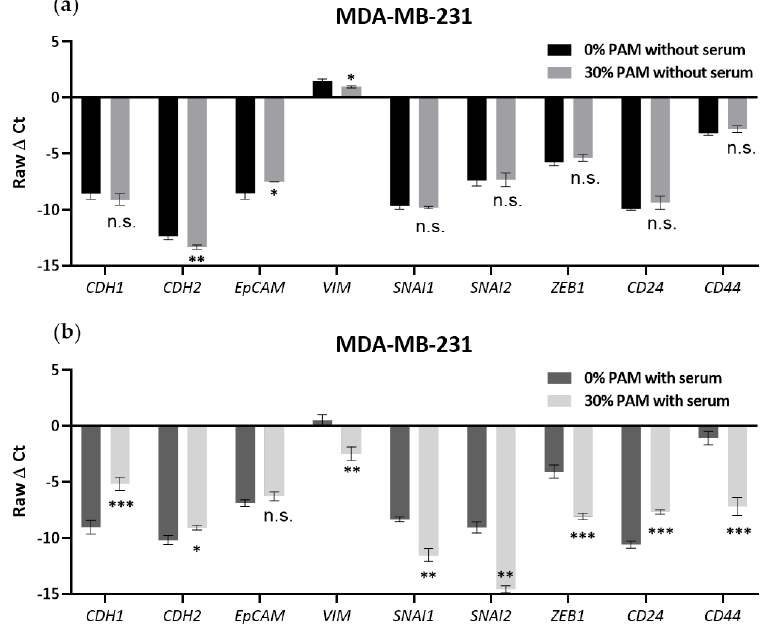
Figure 5 . Changes in EMT markers after PAM treatment without or with serum. MDA-MB-231 cells were plated in a 48- well plate overnight and treated with 0% or 30% 10PAM without ( a ) or with 10% serum ( b ) for 3 days. Epithelial (CDH1), mesenchymal (CDH2, EpCAM, VIM, SNAI1, SNAI2, ZEB1), and stemness (CD24, CD44) markers were detected via real- time RT-qPCR. The mean and SEM of the average for each data point from each of the 3 experiments are shown. “*” represents a p < 0.05, “**” represents a p < 0.01, “***” represents a p < 0.001, and “ns” represents not significant. 3.6. The 3D Bladder Spheroid Model Confirms the Association of the Mesenchymal State and Cell Sensitivity to PAM Selective responsivity to PAM treatment in mesenchymal cell variants was also seen in 3D bladder cancer cell line spheroids treated for 6 days. Activated caspase-3/7 staining was used to monitor apoptosis in spheroids, and Hoechst 33342 dye was used to counter- stain the DNA (Figure 6a,b). PAM treatment (50% 10PAM gently mixed with the sphe- roids) induced apoptosis in all cell lines, with the TSU-Pr1-B2 showing less response than the -B1 or TSU-Pr1 cells (Figure 6a,b; representative spheroid pictures with green stain- ing). Morphology of the spheroids became apoptotic, consistent with caspase-3/7 staining, and spheroids had a consistently lower area when measured in random fields after treat- ment with either cisplatin (standard-of-care chemotherapy for MIBC) or PAM (Figure 6c). Although this was only a single pilot experiment, the association of PAM response with epithelial/mesenchymal nature appeared to be consistent with the 2D results as men- tioned above.